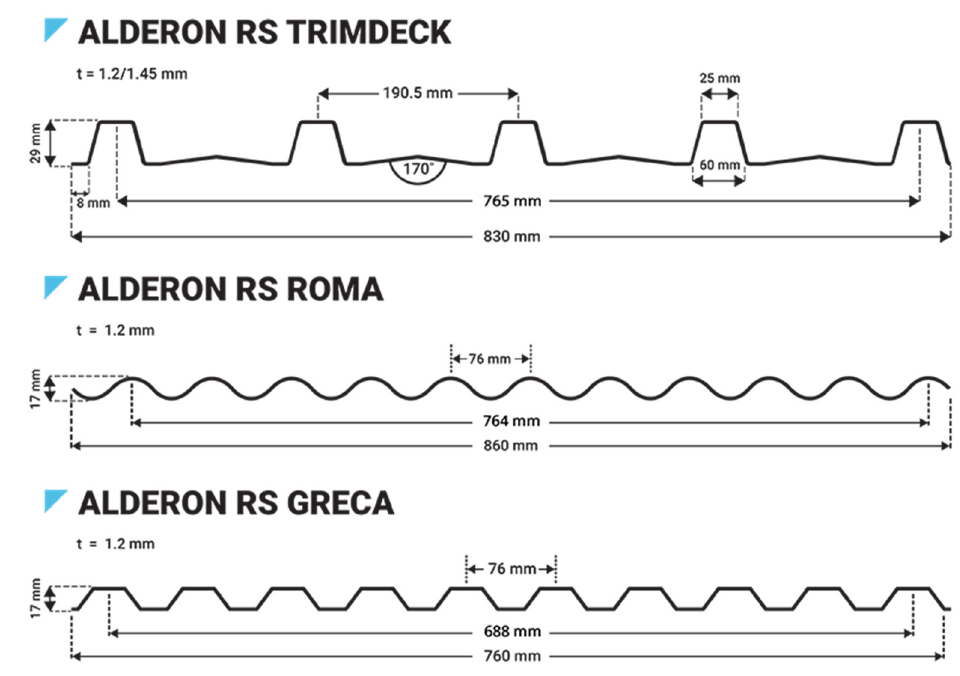
Figure 3. Alderon RS ® specification.